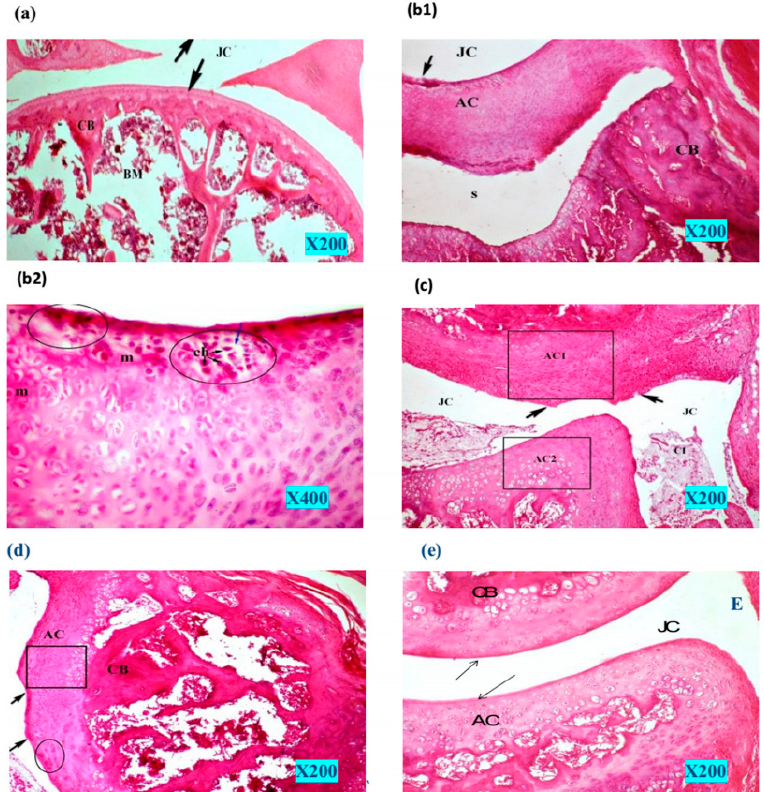
Figure 4. Histopathology photomicrographs of knee joint tissue. Normal control group ( a ), mono-iodoacetate (MIA) control group ( b1 ), and higher magnification ( b2 ). Free colchicine aqueous solution-treated rat group ( c ). Formula 1 (transdermal hydrogel patch comprising colchicine)-treated rat group ( d ). Formula 2 (the transdermal hydrogel patch comprising the equivalent amount of colchicine encapsulated in mesoporous silica nanoparticles)-treated rat group ( e ). Articular hyaline cartilage (AC), joint cavity (JC), compact bone (CB), bone marrow (BM), chondrocytes (Ch), cellular infiltration (CI) [110].